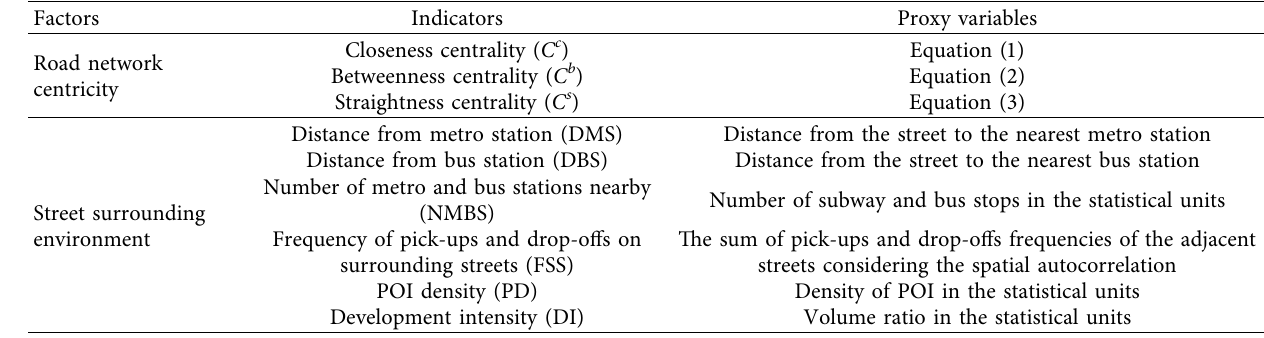
Table 2: Indicator